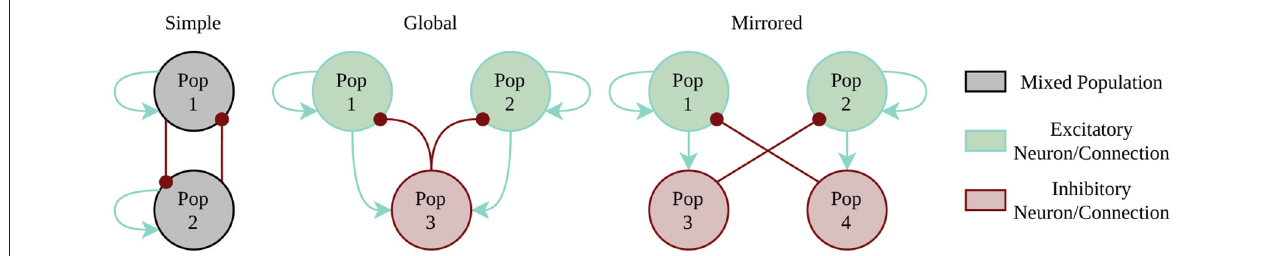
FIGURE 3 | Winner-Takes-All implementation styles. Random spike source are not included in the picture, as every neuron of the excitatory populations (1 and 2) has a one-to-one connection to its individual Poisson spike